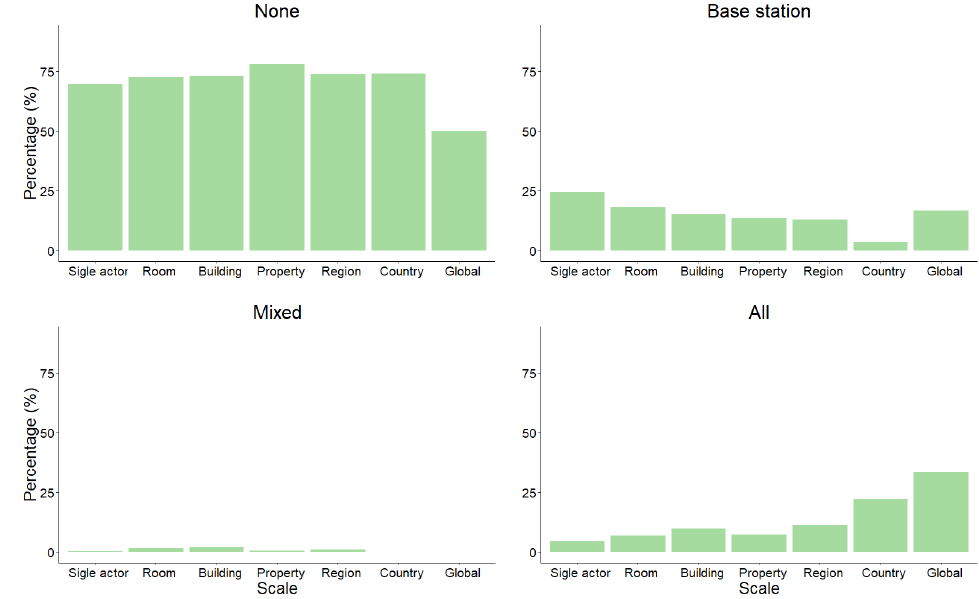
Figure 17. Deployment scale distribution between usage of rich